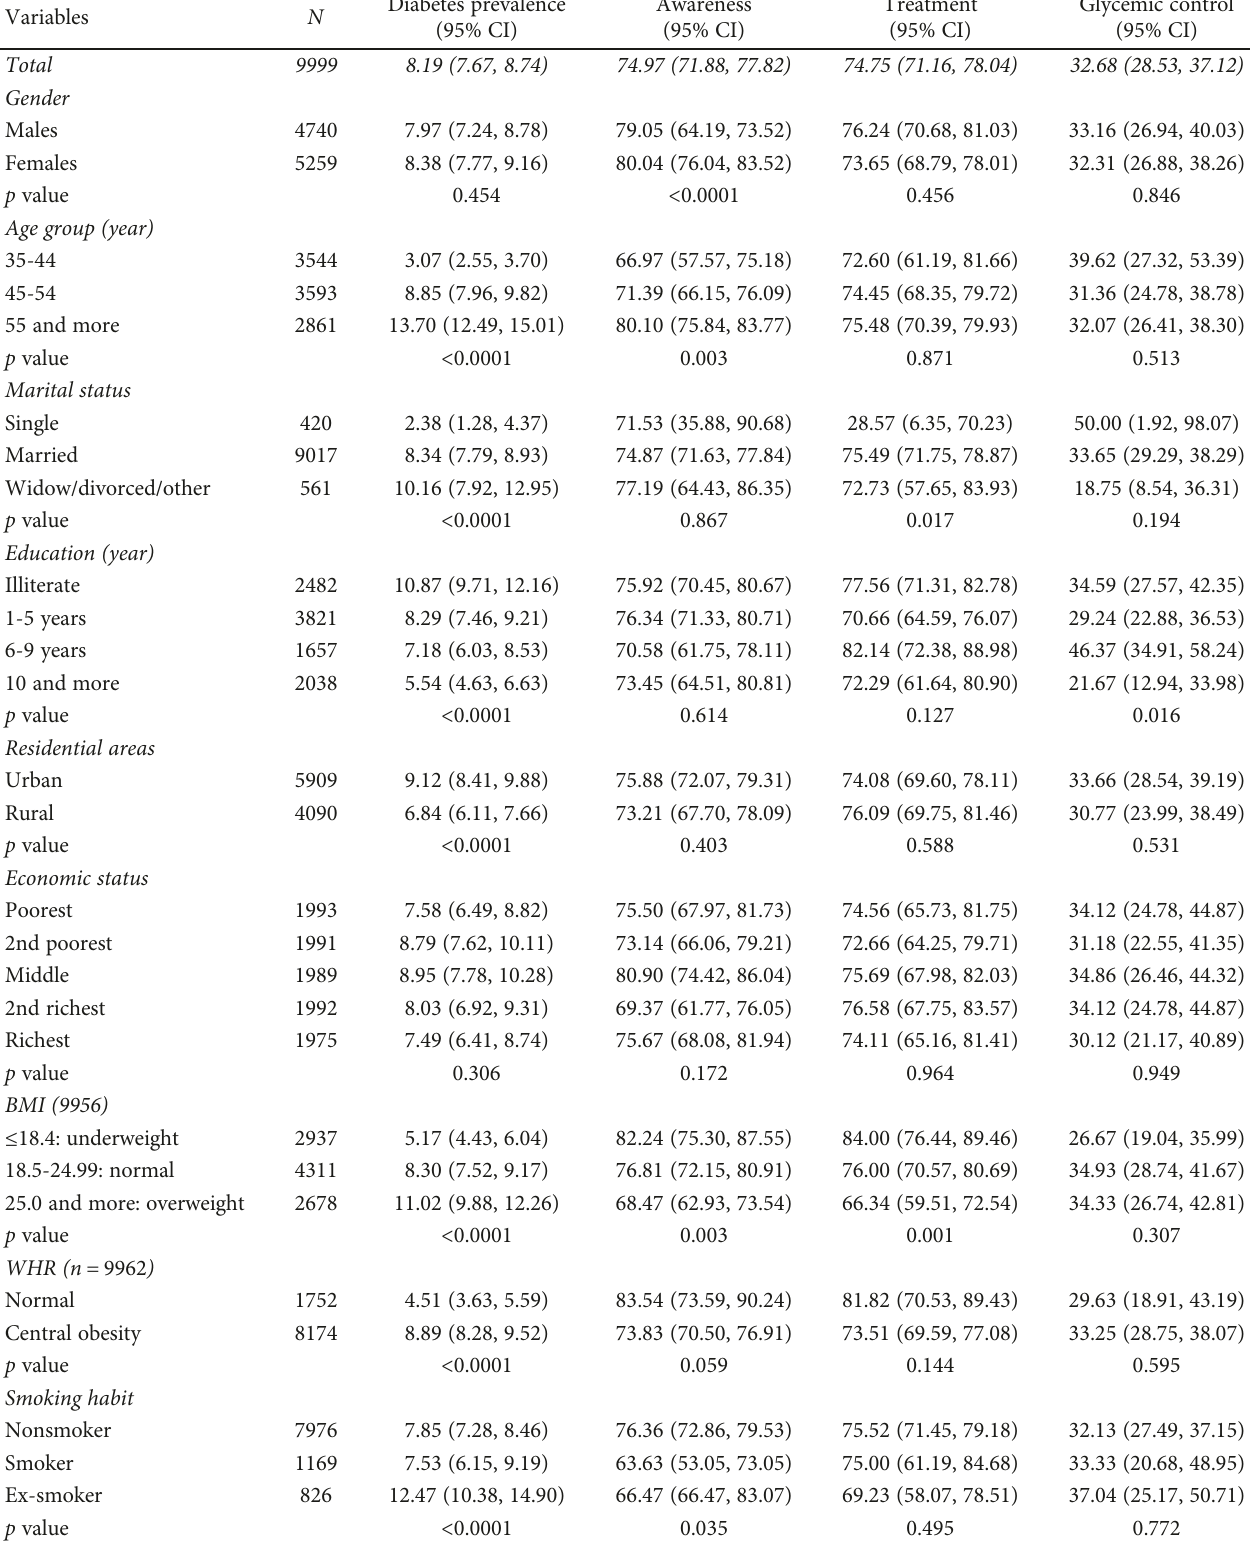
Table 1: Prevalence, awareness, treatment, and glycemic control of diabetes by other important factors in the RaNCD cohort study.